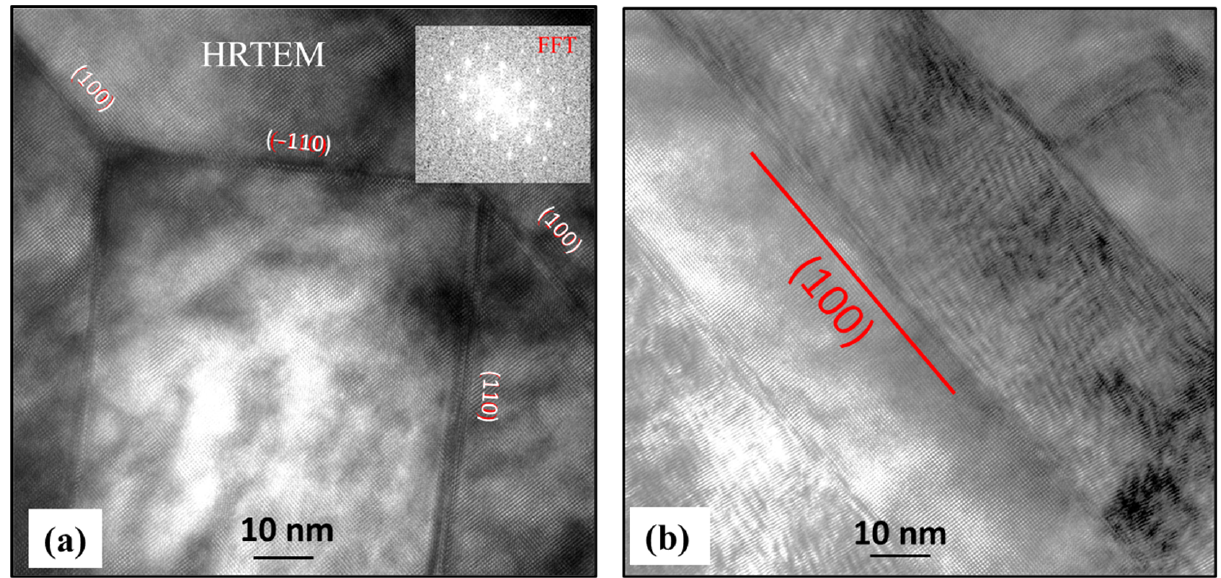
Figure 9. HRTEM images of ferro-elastic domain boundaries in faulted (F) grains; inset: fast Fourier transform of lattice image. Domain boundaries exhibit {100} and {110} nature with 45 ◦ or 90 ◦ angles of inclination between themselves; ( b ) other domains to the left of ( a ).